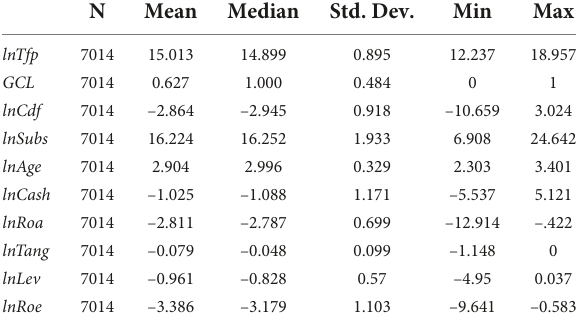
TABLE 1 Descriptive statistics of